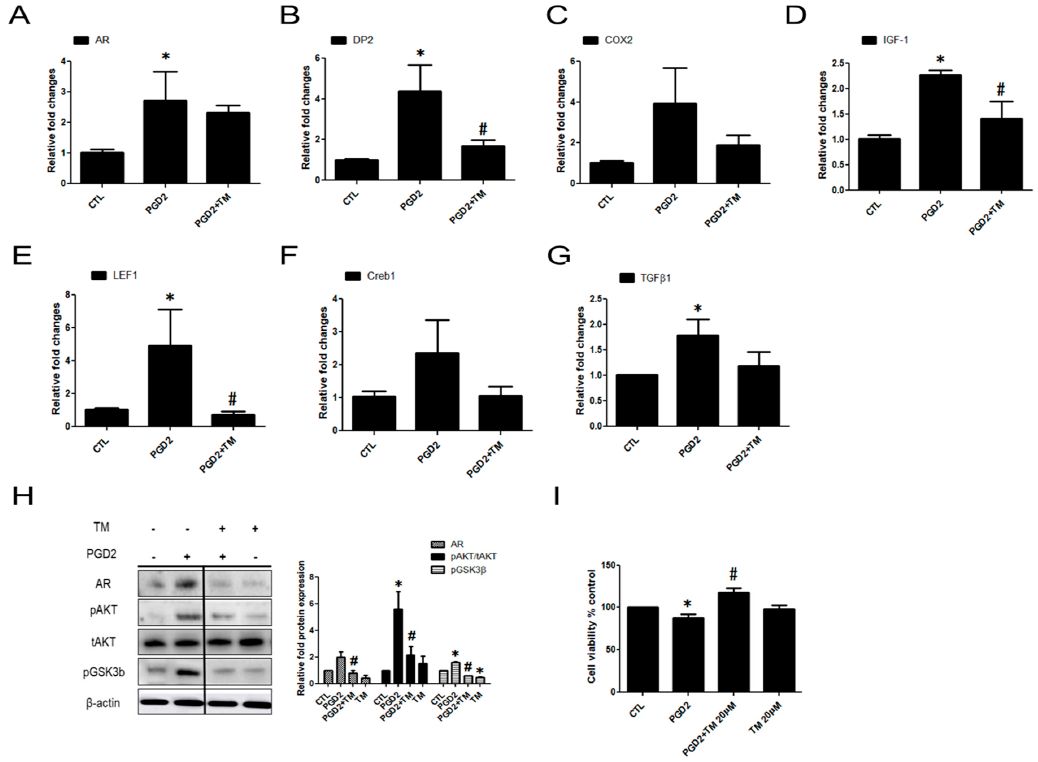
Figure 4. The effect of a DP2 antagonist on PGD2-induced AR related genes and AKT signalling in hDPCs. hDPCs were pretreated with TM30089 (20 µ M) or LY294002 (20 µ M) for 1 h and then stimulated with 200 nM PGD2 for 24 h. The mRNA expression of AR, DP2, COX2, IGF-1, LEF1, Creb, and TGF β 1 was measured by qRT-PCR ( A – G ). hDPCs in serum-free DMEM were pretreated with TM30089 (20 µ M) for 1 h and then stimulated with 200 nM PGD2 for 5 h. The protein level of AR, and AKT/GSK3 β phosphorylation was measured using western blot analysis. The histogram shows quantitative representation of the levels of PGD2-induced phosphorylation obtained from a densitometric analysis of three independent experiments ( H ). An MTT-based assay was performed to determine the effects of PGD2 after 72 h of treatment. TM30089 (20 µ M) restored the viability of hDPCs that was inhibited by 200 nM PGD2 ( I ). β -actin served as a loading control for protein normalization. GAPDH was used as an internal control for mRNA normalization. The results are expressed as the mean ± SD of three independent experiments. TM; TM30089, * p < 0.05 compared with the control (0 nM PGD2), # p < 0.05 compared with